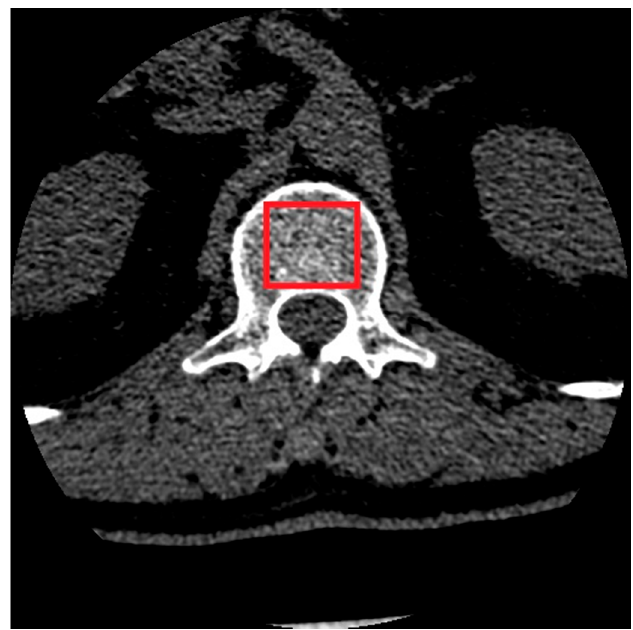
Figure 2. Manual selection of the spongy matter region.